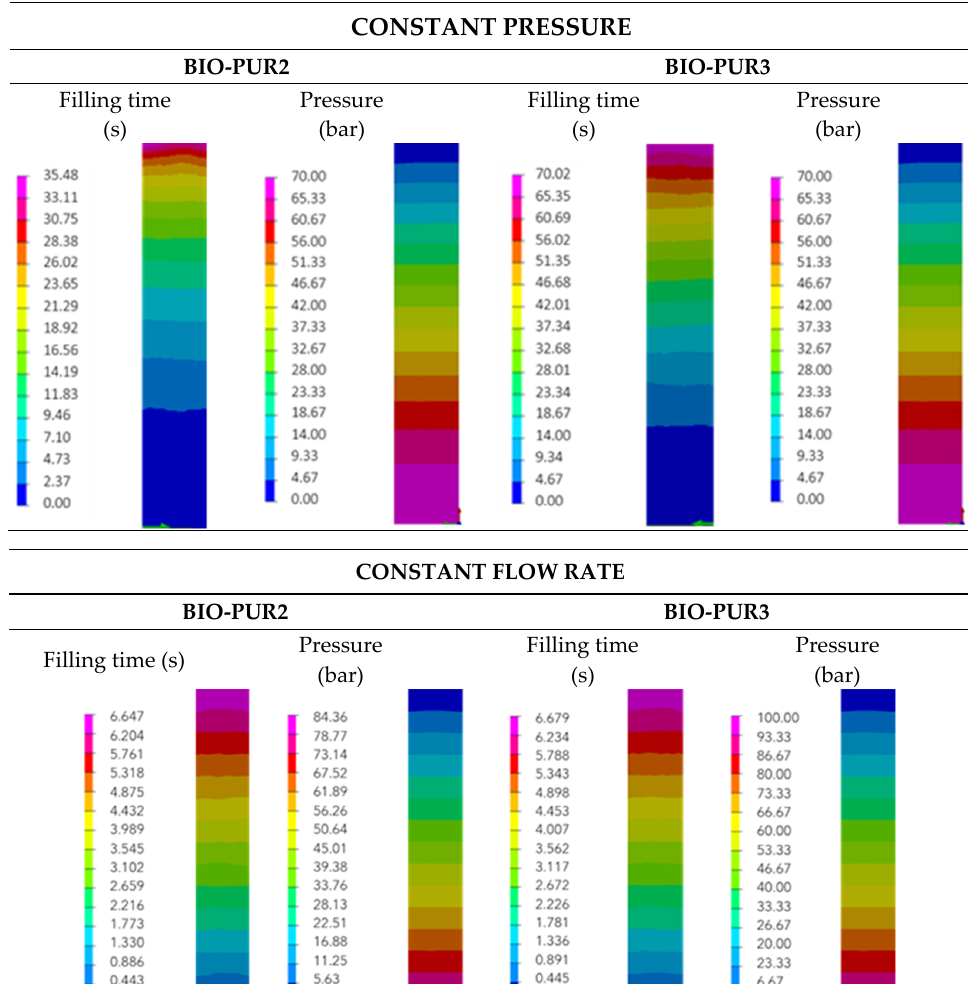
Figure 7. Viscosity evolution with time at 90 °C for BIO-PUR2 and BIO-PUR3. Experimental results (symbols) and model (red lines).